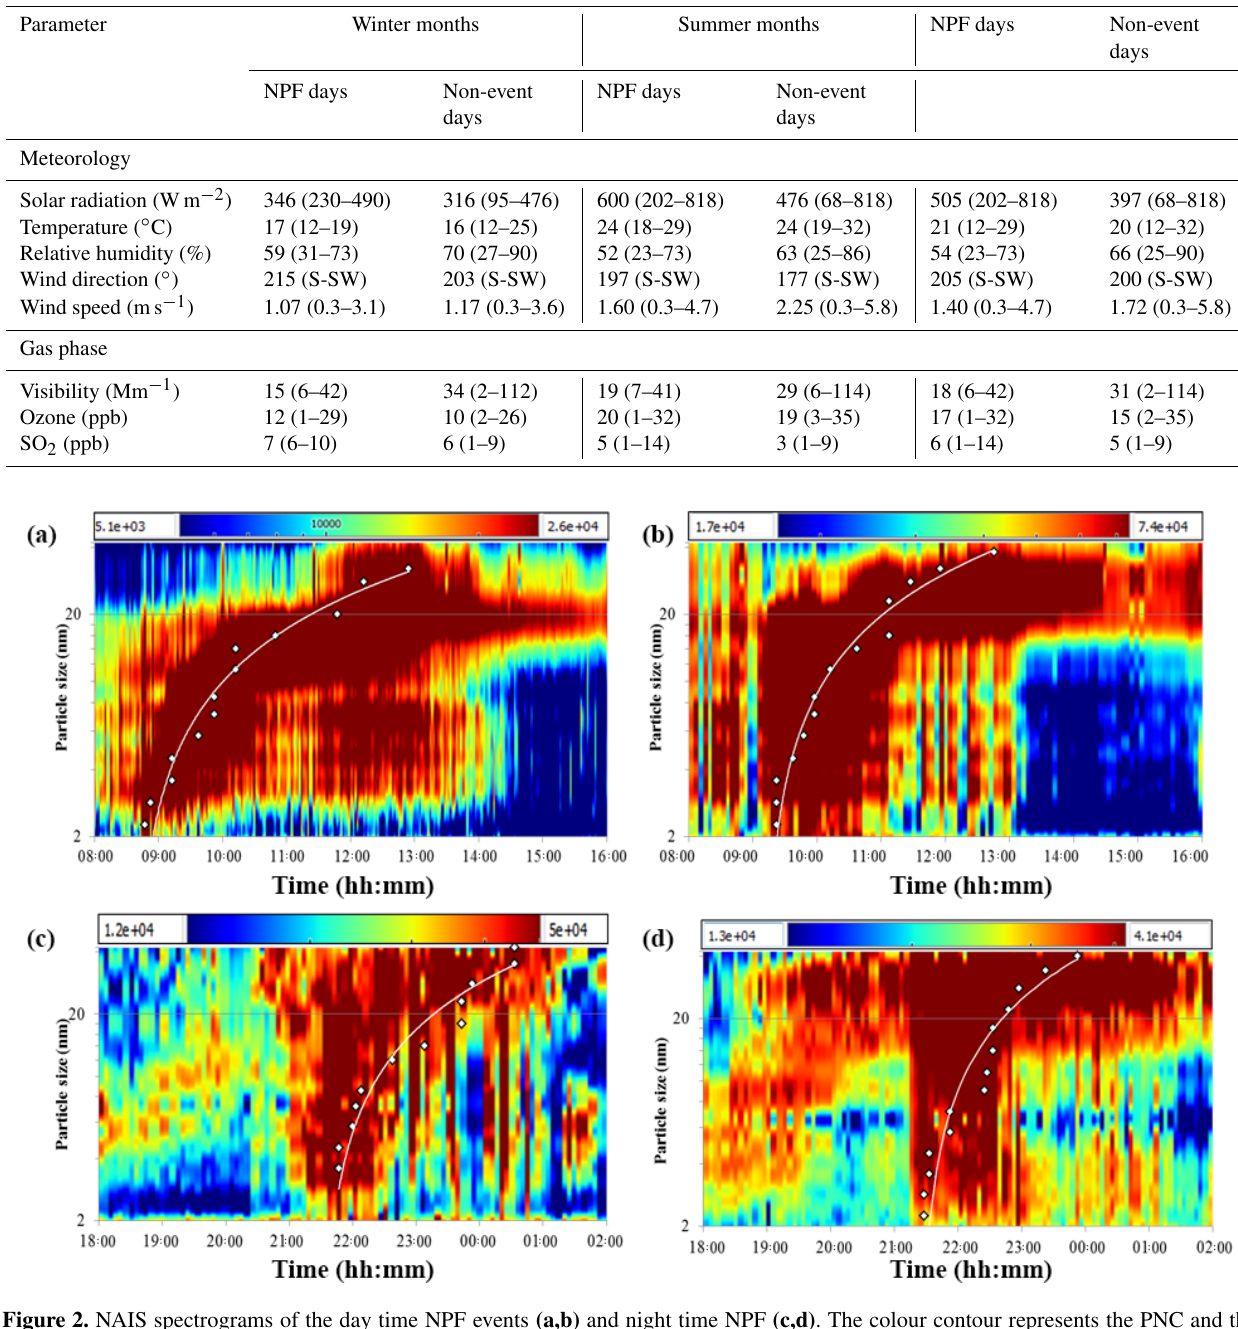
Table 3. The mean and the range of meteorology and gas phase parameters on NPF and non-event days. Parameter